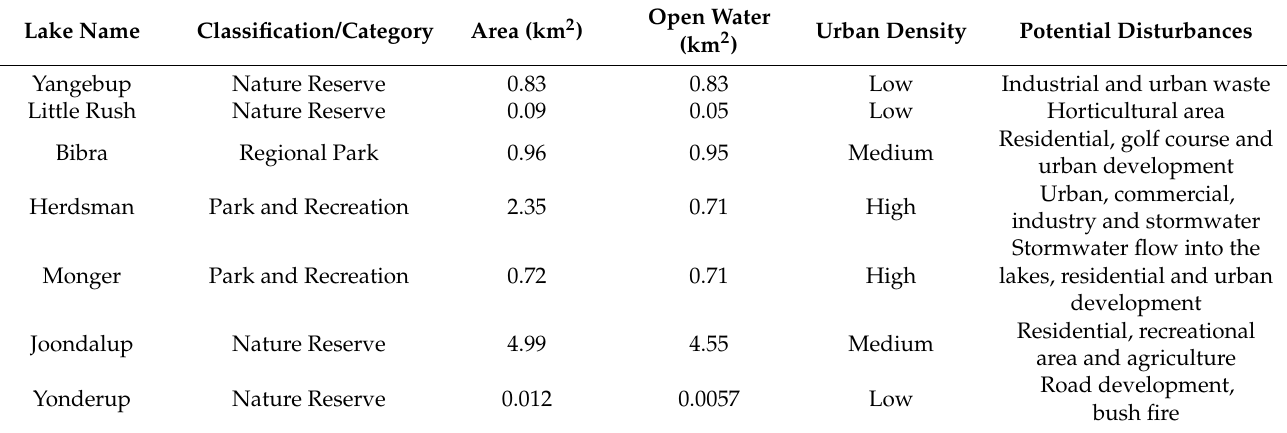
Figure 1. Map of the locations of the studied lakes along the Swan Coastal Plain, Western Australia. The seven lakes selected for this study are Lake Yangebup, Little Rush Lake, Bibra Lake, Lake Monger, Herdsman Lake, Lake Joondalup, and Lake Yonderup. Table 1. General information of the studied lakes. Classification or category as described by the Western Australian Department of Parks and Wildlife (DPAW); urban density was classified as low, medium, or high based upon the percentage of built-up area.